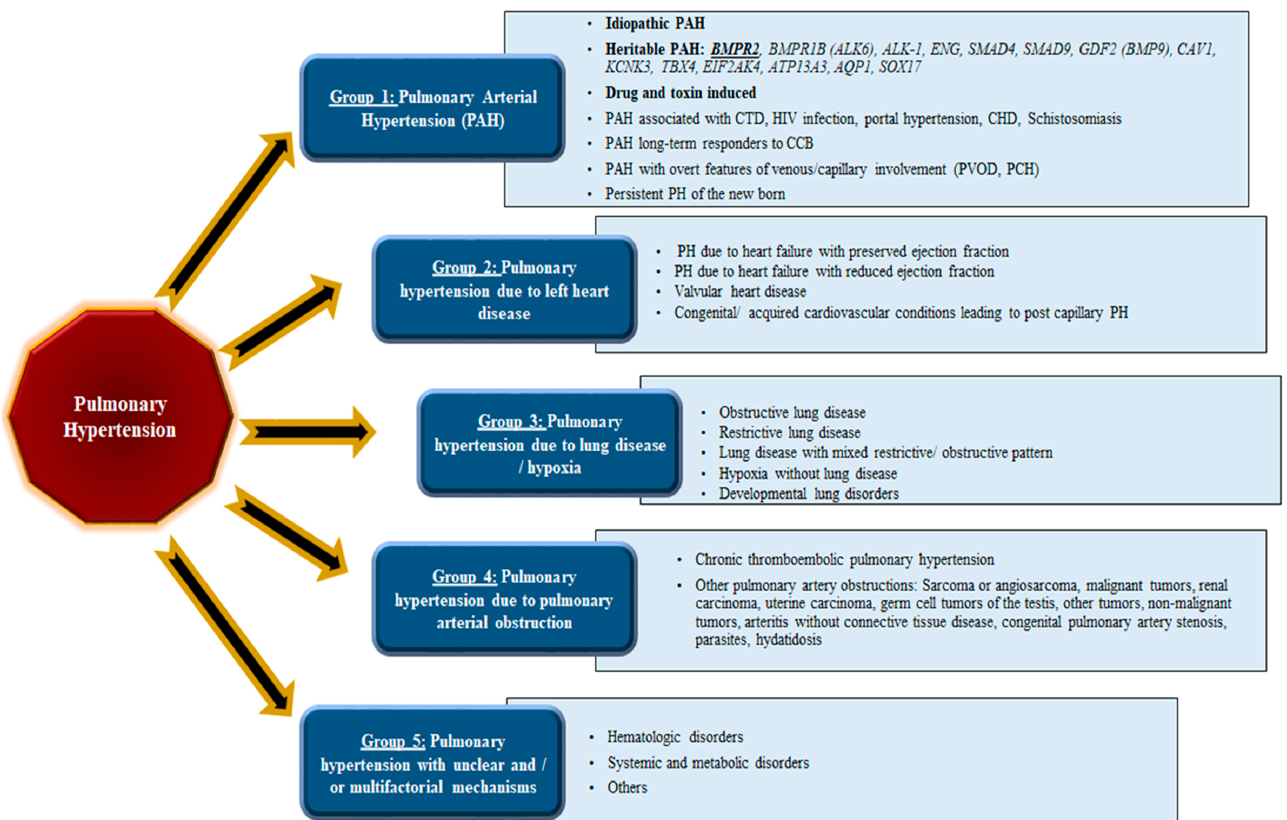
Figure 1. Updated clinical classification of pulmonary hypertension (PH), comprising five distinct groups based on recommendations from world experts at the most recent World Symposium on Pulmonary Hypertension.